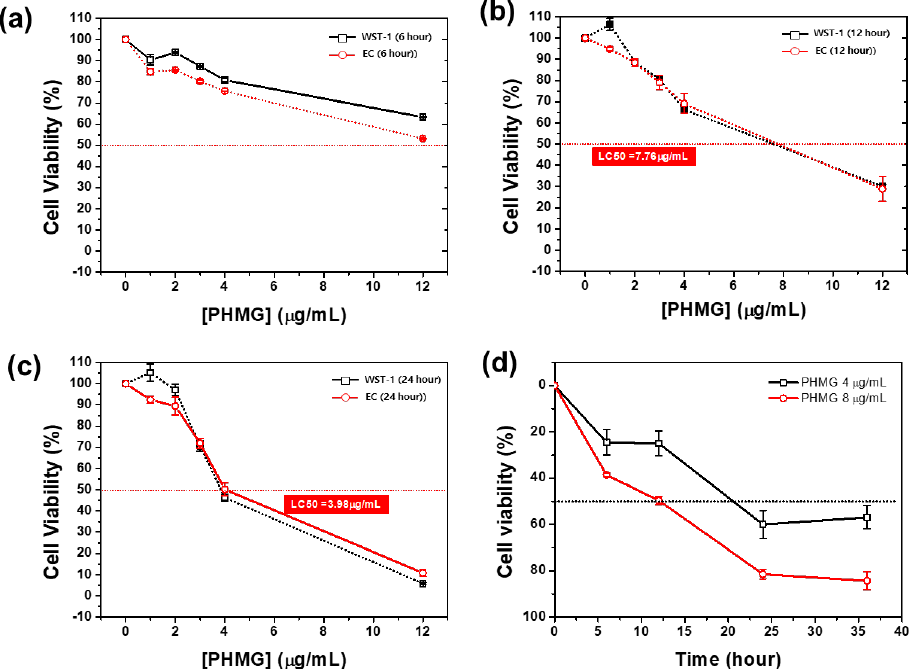
Figure 3. ( a ) 6-h assay; ( b ) 12-h assay; ( c ) 24-h assay; and ( d ) Continuous cell viability monitoring of PHMG-induced cells (n = 5).